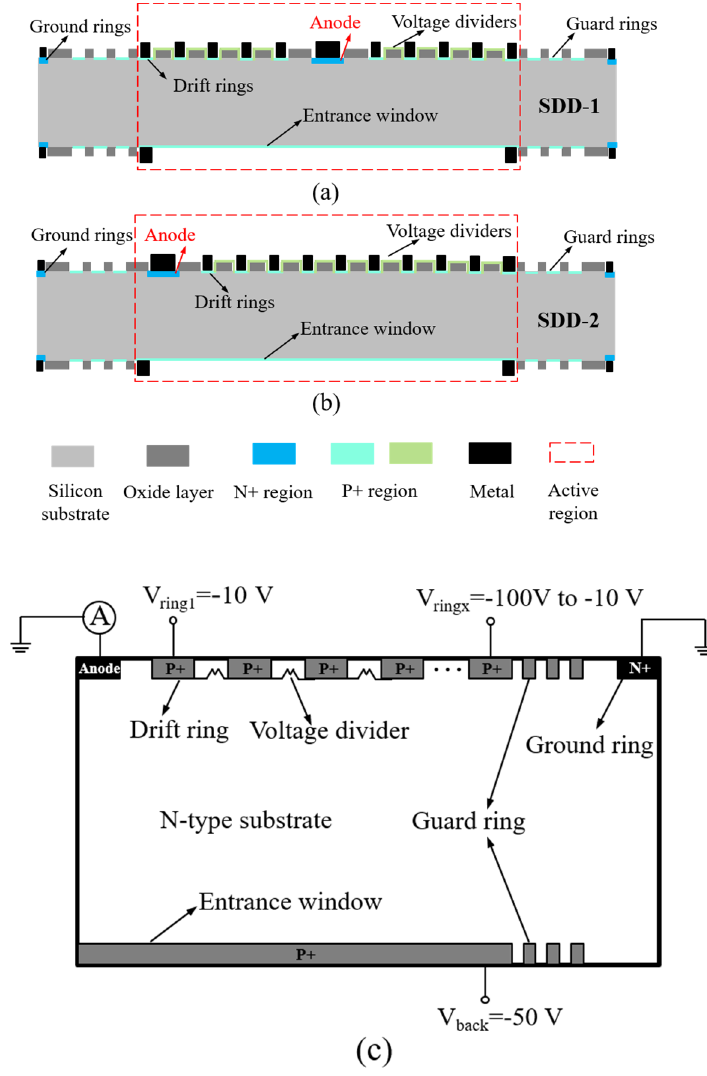
Figure 2. The schematic diagram of cross-section of the two square-SDD structures: ( a ) The anode is located in the center of the active region (SDD-1). ( b ) The anode is located on the left edge of the active region (SDD-2). ( c ) A schematic of the setup for measuring the anode current of the two SDDs.